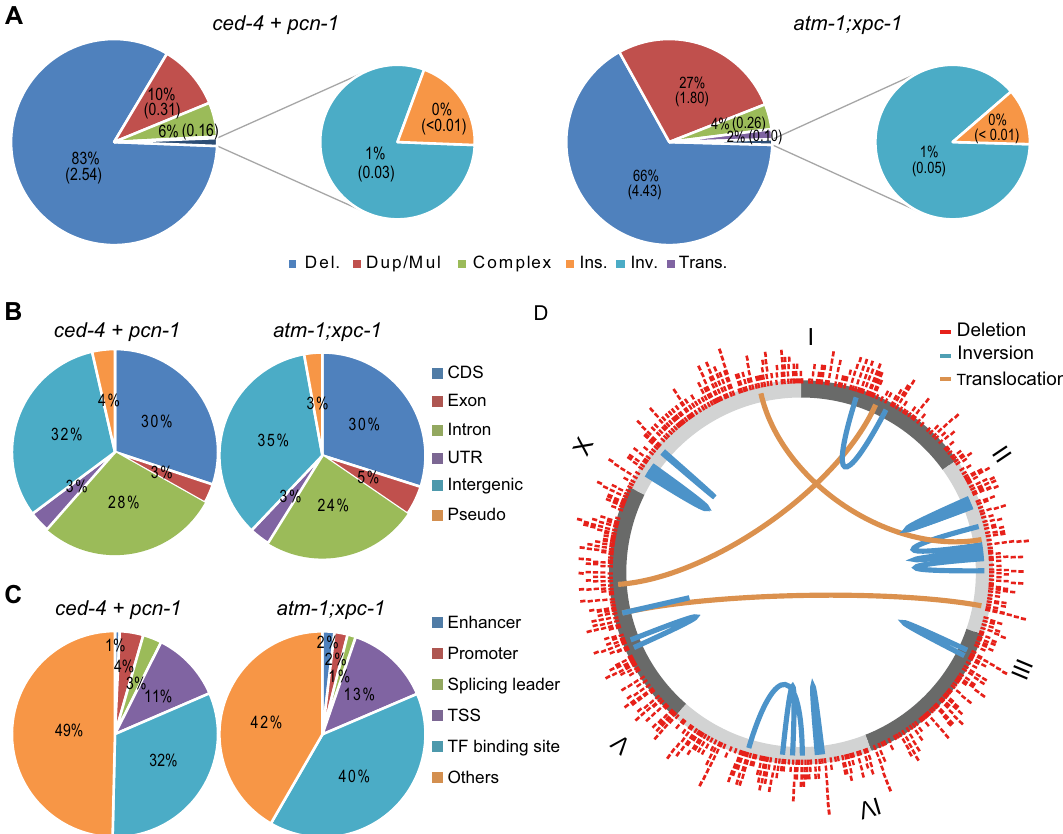
Figure 5. Large scaled NGS. The whole genome of 10, 124, and 306 strains derived from pcn-1 , ced-4 , and atm- 1;xpc-1 were sequenced, and homozygous variants were detected, respectively. ( A ) The colored pie graph shows the frequency of variants. Deletions (blue), duplications and multiplications (red), and complex deletion with insertion (green), and insertion (violet) are shown in large pie graphs, and inversions (cyan), and translocations (orange) were shown in small pie graphs. The distribution of each type of variants were different between atm- 1;xpc-1 and the group of ced-4 and pcn-1 (p-value is 1.7e-4, chi-square test). ( B ) The variants were annotated and classified into the 6 types, CDS (blue), exon (red), intron (green), UTR (violet), intergenic region (cyan), and pseudogene (orange). There was no difference among the strains (p-value is 0.38, chi-square test). ( C ) The variants annotated as intergenic regions in ( B ) were classified into the following 6 types, enhancer (blue), promoter (red), splicing leader (green), transcription start site (TSS, violet), transcription factor (TF) binding site (cyan), and the others (orange). There was no difference among the strains (p-value is 0.18, chi-square test). ( B , C ) For the annotation, we used datasets obtained from WormBsae 43 (WS252, ftp:// ftp. wormb ase. org/ pub/ wormb ase/). ( D ) The positions of deletions (red) and rearranged variants were shown as a circular diagram using our script (https:// github. com/ YujiS ue/ RScri pt/ blob/ master/ round Graph.R). The break sites of 16 inversions (cyan) and 3 translocations (orange) detected from ced-4 and atm-1;xpc-1 (Supplementary Tables S5, S9) were joined by the colored curves in the circle. All statistical analyses were performed using R software 56